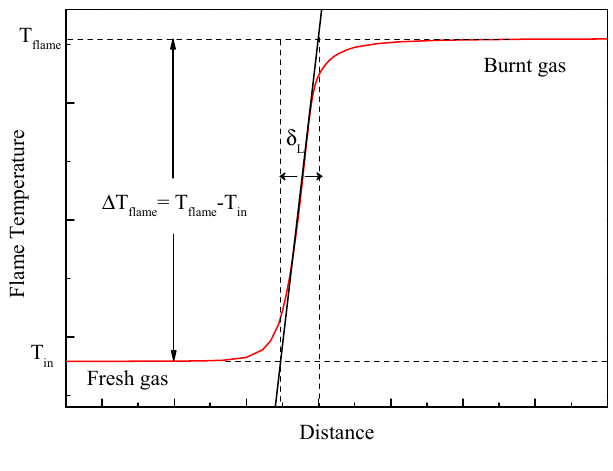
Figure 11. Calculation of flame thickness. Table 2. The flame thickness at lean blowout (LBO) equivalence ratio.